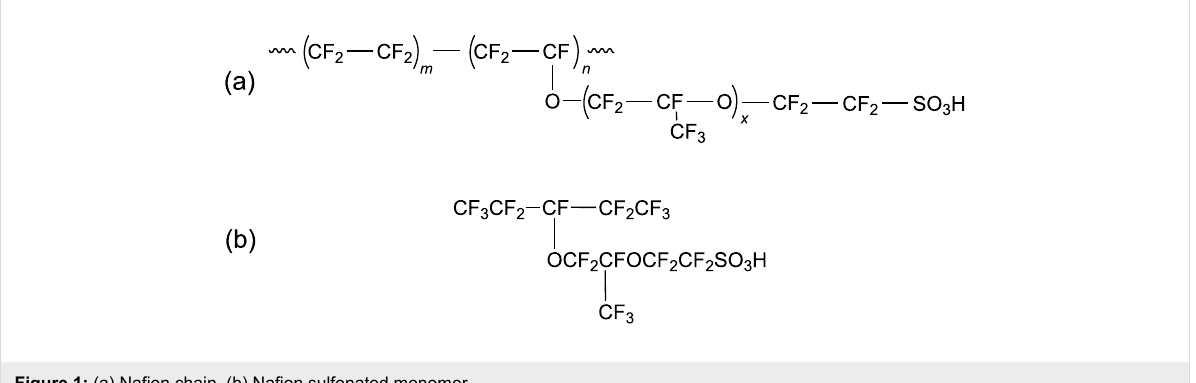
cathode; also, it serves as a barrier to fuel gas cross-leaks